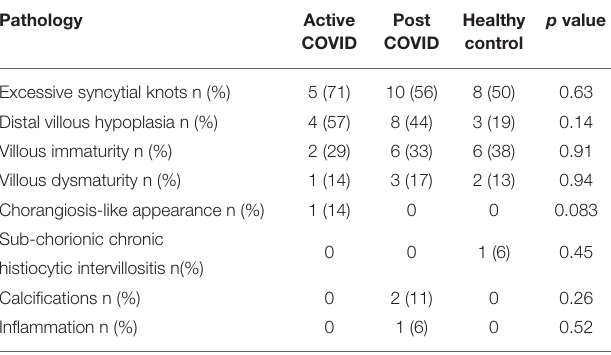
TABLE 2 | Summary of histopathology findings in placentas from Active COVID, Post COVID, and healthy control groups.